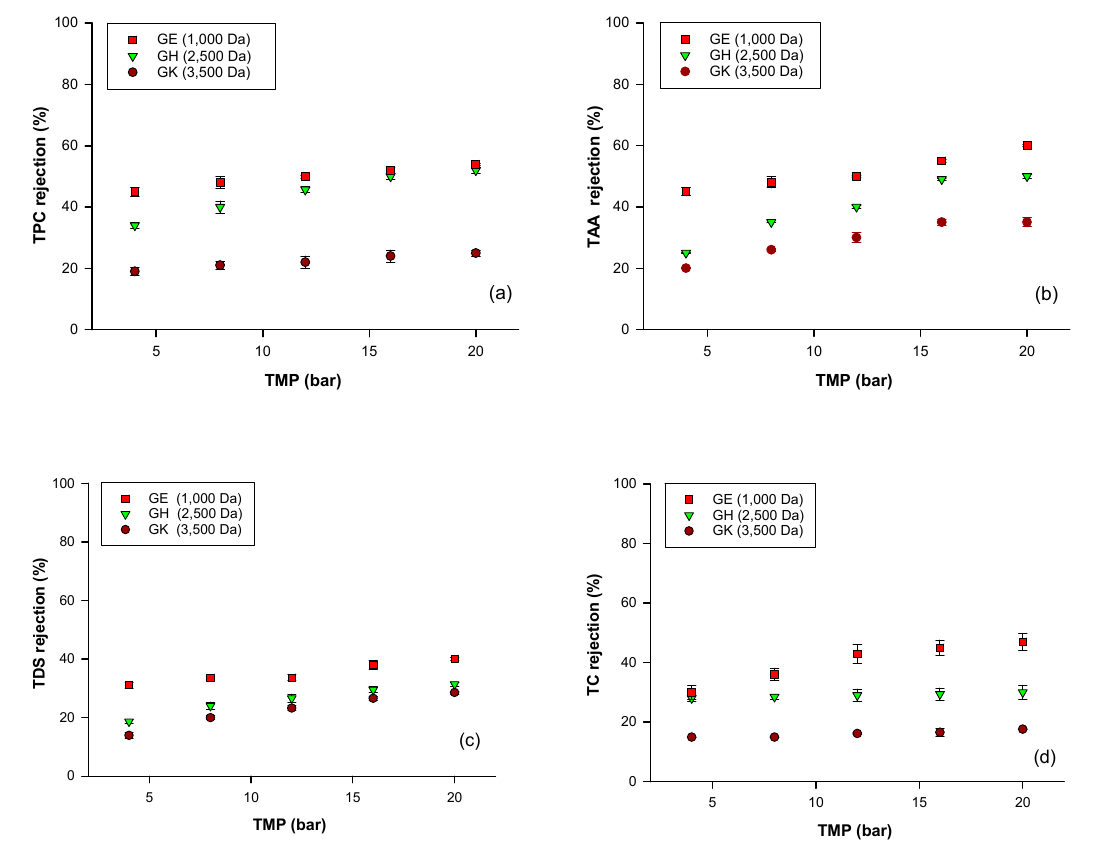
Figure 4. Influence of TMP and MWCO of selected membranes on the rejection of analyzed compounds. ( a ) TPC, total phenolic content; ( b ) TAA, total antioxidant activity; ( c ) TDS, total dissolved solids; ( d ) TC, total carbohydrates.